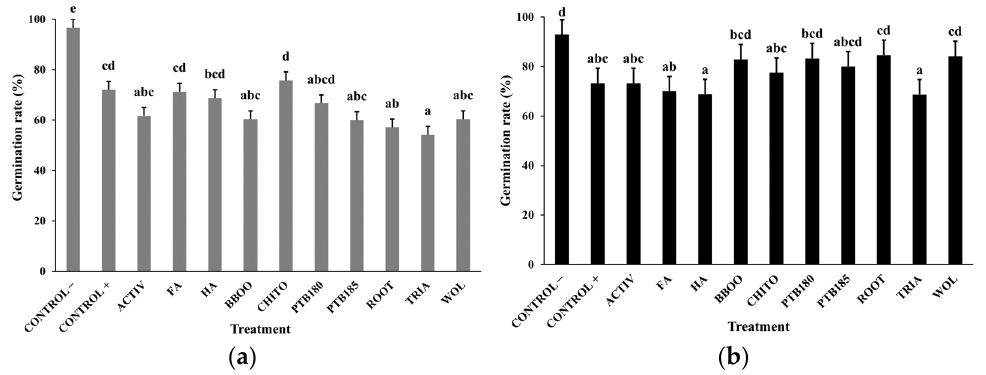
Figure 1. Effect of biostimulants on the germination rate of baby leaf lettuce seeds sown in a substrate inoculated with Pythium ultimum under organic ( a ) and conventional ( b ) management. Substrate was drenched with Ascophyllum nodosum extract (ACTIV), fulvic acid (FA), humic acid (HA), bamboo vinegar (BBOO), chitosan (CHITO), Bacillus pumilus PTB180 (PTB180), Bacillus subtilis PTB185 (PTB185), Trichoderma harzianum T-22 (ROOT), triacontanol (TRIA), or wollastonite (WOL). Control seeds were sown in a substrate that was drenched with water (no biostimulants) and inoculated with P. ultimum (CONTROL+) or non-inoculated with P. ultimum (CONTROL − ). Each value represents the mean of 8 replicates ± standard error. Means sharing a same letter are not significantly different according to Fisher’s protected LSD test ( p ≤ 0.05).